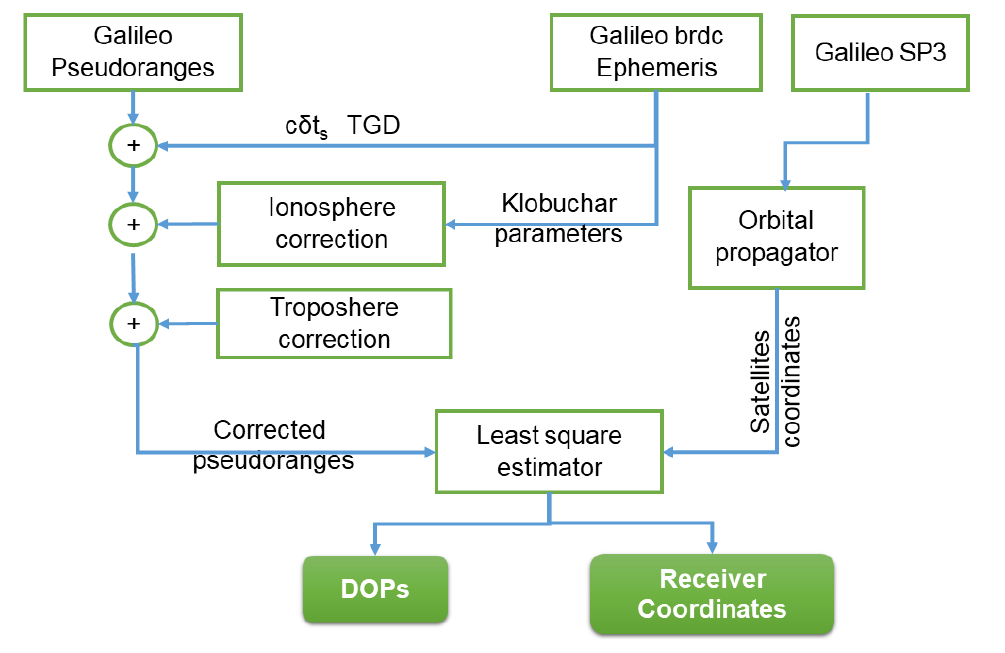
Figure 2. Flowchart representation of the algorithm developed for the determination of receiver position and Dilution Of Precision (DOP) parameters; TGD stands for Time Group Delay, while brdc for